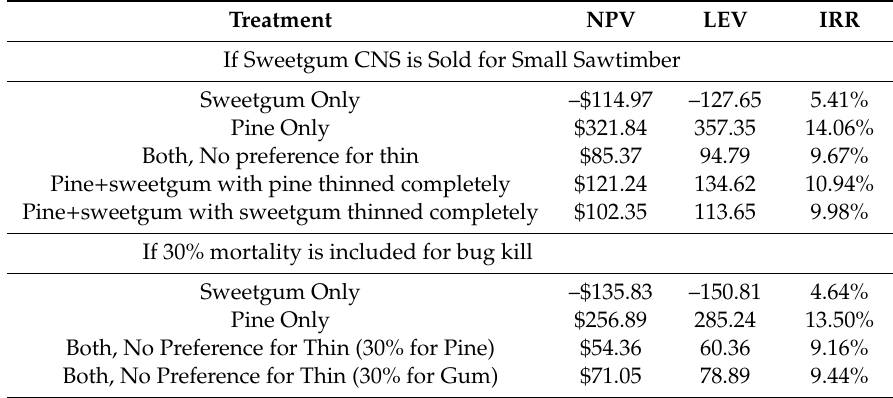
Table 1. Net present value (NPV), land expectation value (LEV), and internal rate of return (IRR) at a 8% interest rate for a 30-year rotation in response to species selection treatments at a site in north central